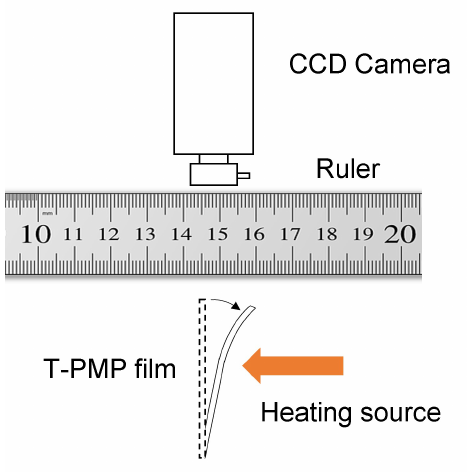
Figure 1. The experimental setup used to measure the behavior of the t-PMP-film under, and after, heat radiation. A CCD camera was used to record motion. The motion of the film under illumination is reported in Figure